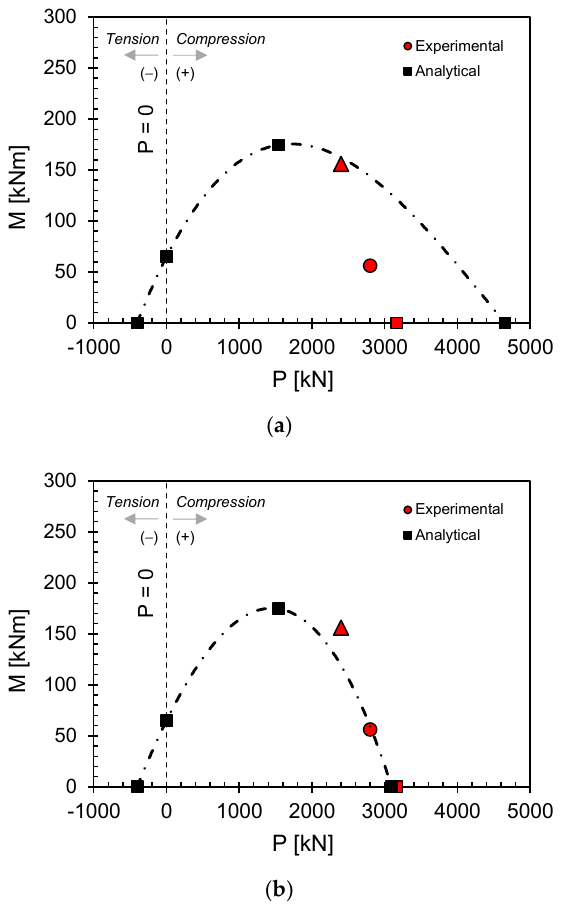
Figure 18. Comparison of experimental axial force-bending (P, M) capacity values and analytical envelopes in which the pure compression point is computed through Equation (5) ( a ) and Equation (10) ( b ).